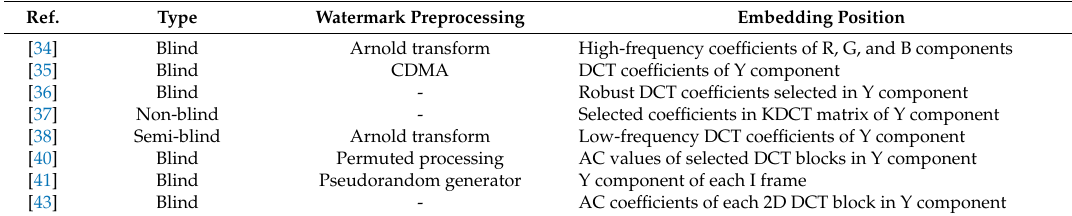
Table 3. Summary comparison of several watermarking algorithms in DCT domain.